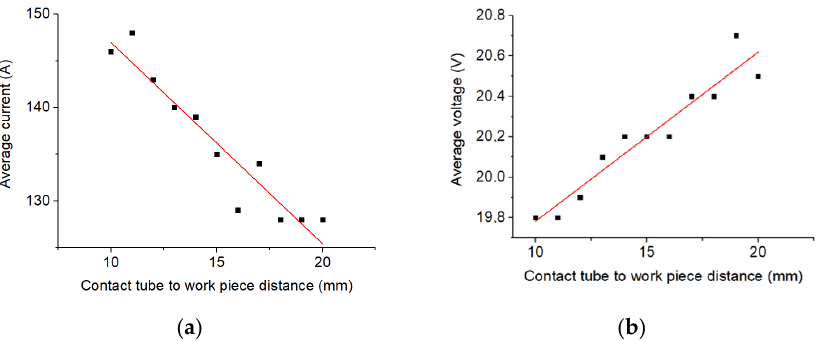
Figure 10. Change in the average cladding current and voltage depending on the electrode stickout, mode I = 120 A, U = 20 V; ( a )—average current, ( b )—average voltage.